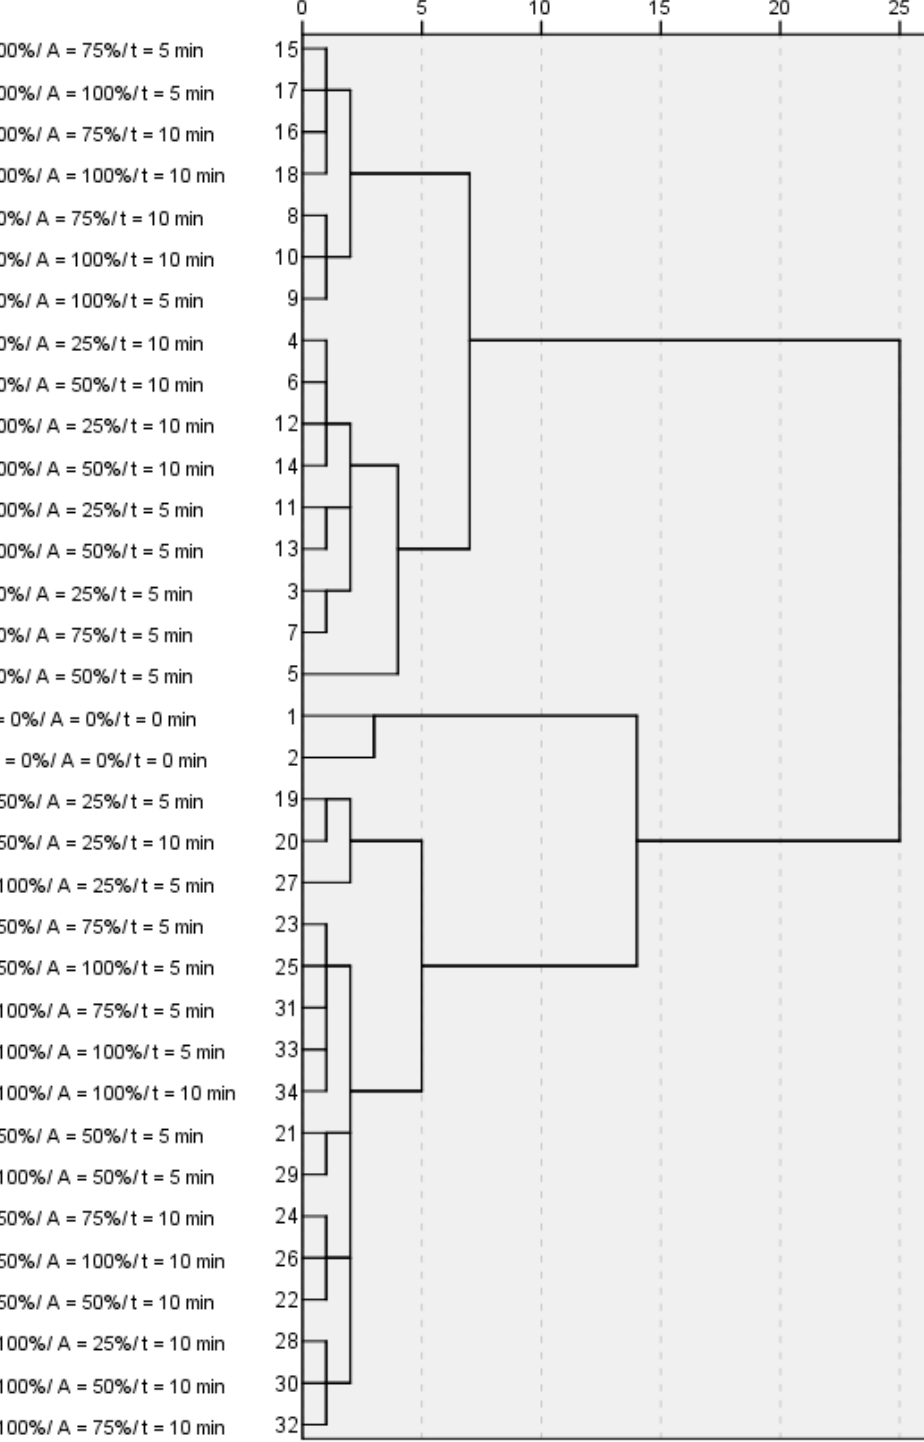
Figure 1. Results of the hierarchical cluster analysis of averaged and standardized samples.